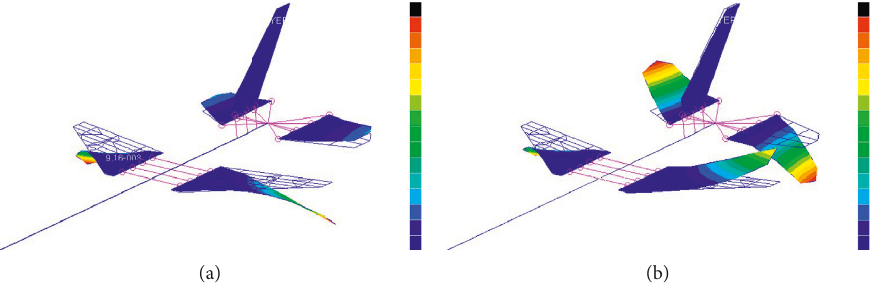
Figure 3: First two elastic mode shapes obtained using the equivalent FE model: (a) first elastic mode and (b) second elastic mode.